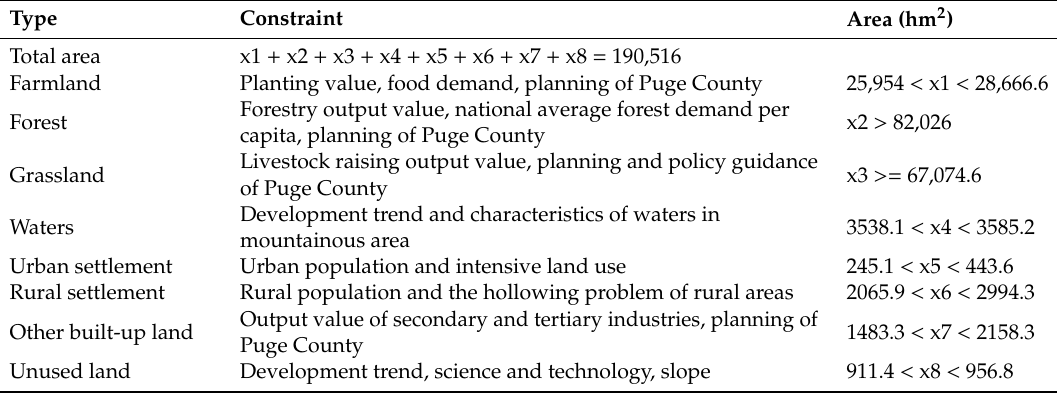
Table 3. Constraints and scope of the area of land use types under the optimized